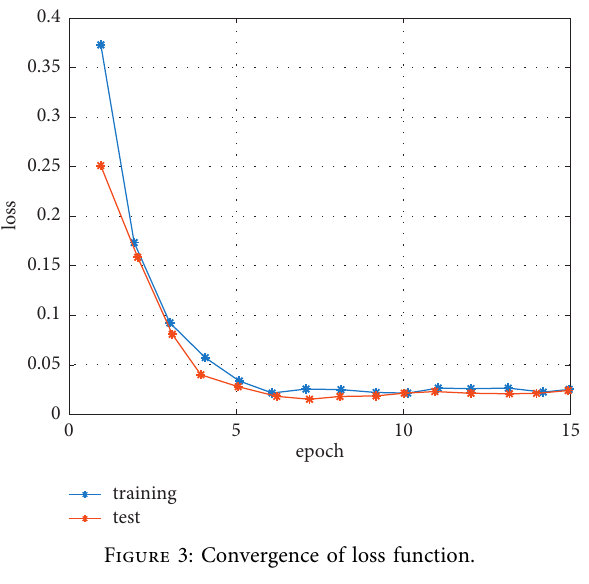
Figure 3: Convergence of loss function.